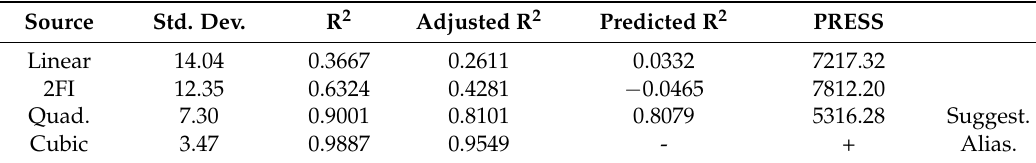
Table 3. Results of the regression analysis considering statistical indicators.